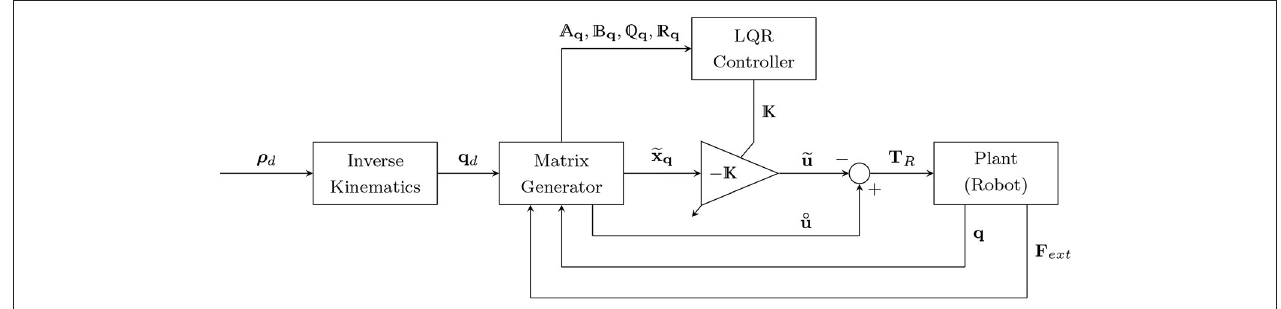
FIGURE 2 | Optimal impedance controller scheme. ρ d and q d are the desired positions in the operational and joint spaces, respectively. u is the optimal control input for the error dynamics, and ˚ u is the nominal control input (desired torque minus the torque caused by the interaction force). (cid:129) q , ‚ q , and ‘ q and ’ q are the time-varying state, input, and LQR gain matrices, e